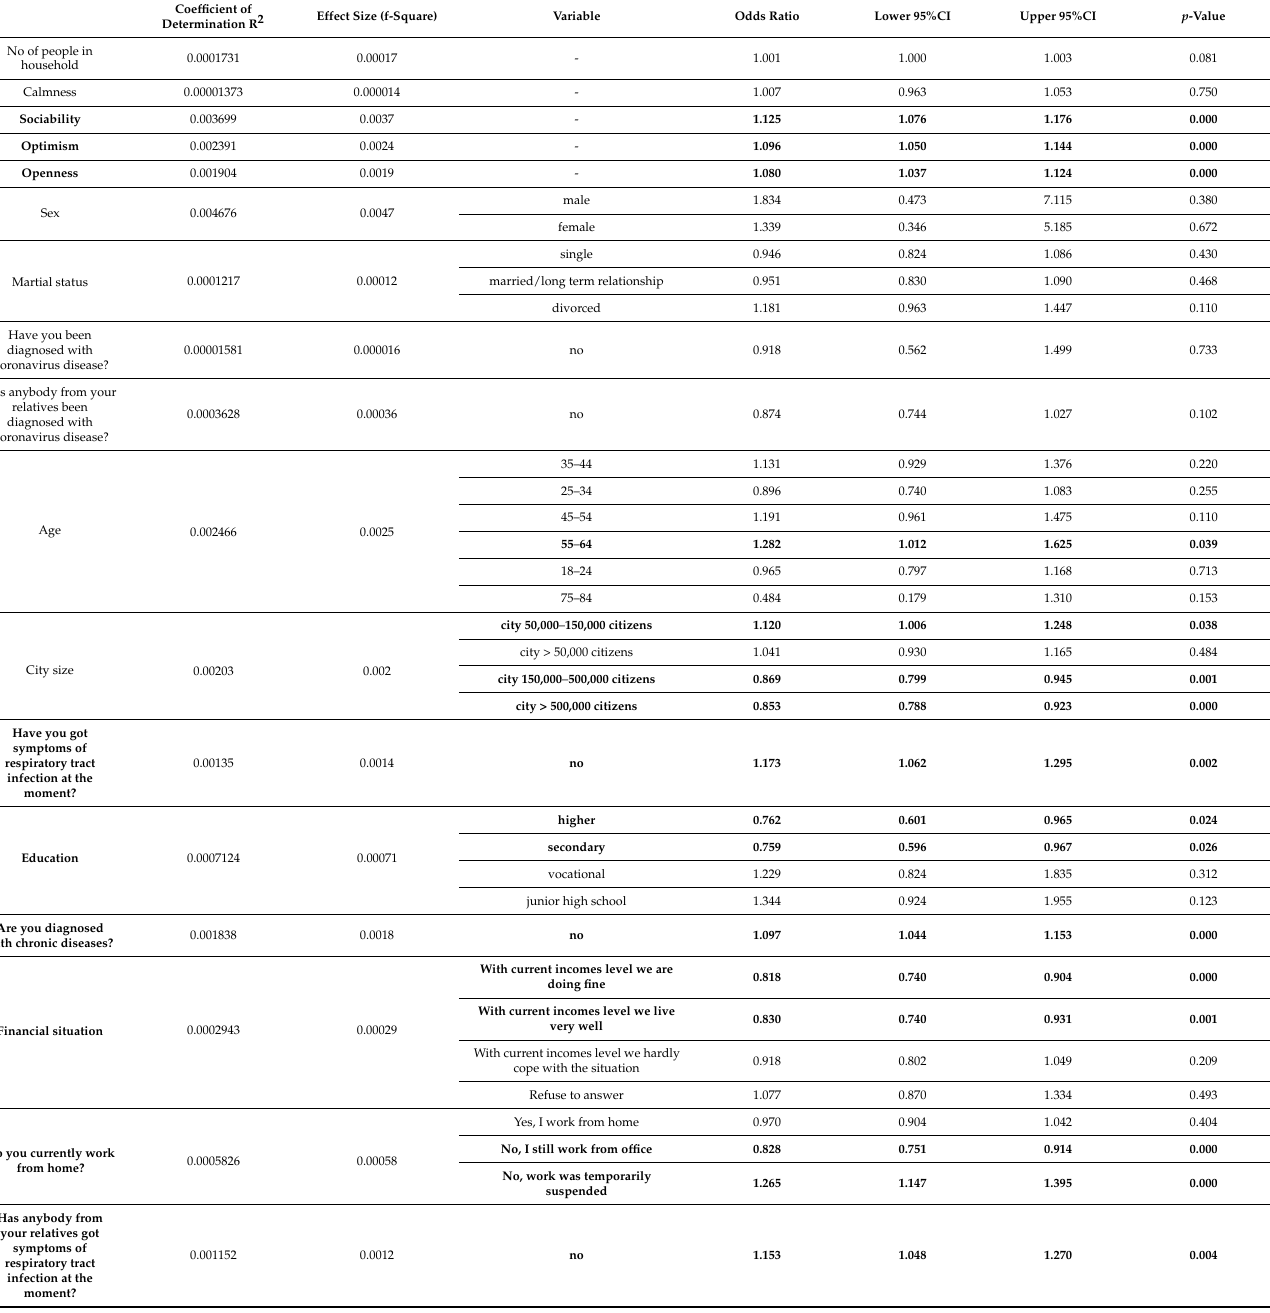
Table 3. Univariate regression analysis for stricter lockdown